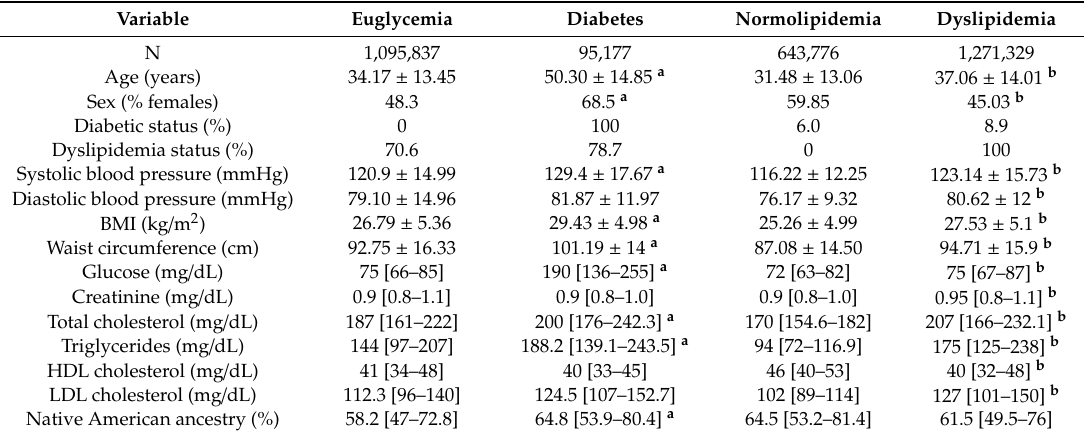
Table 2. Sample description stratified by diabetes and dyslipidemia